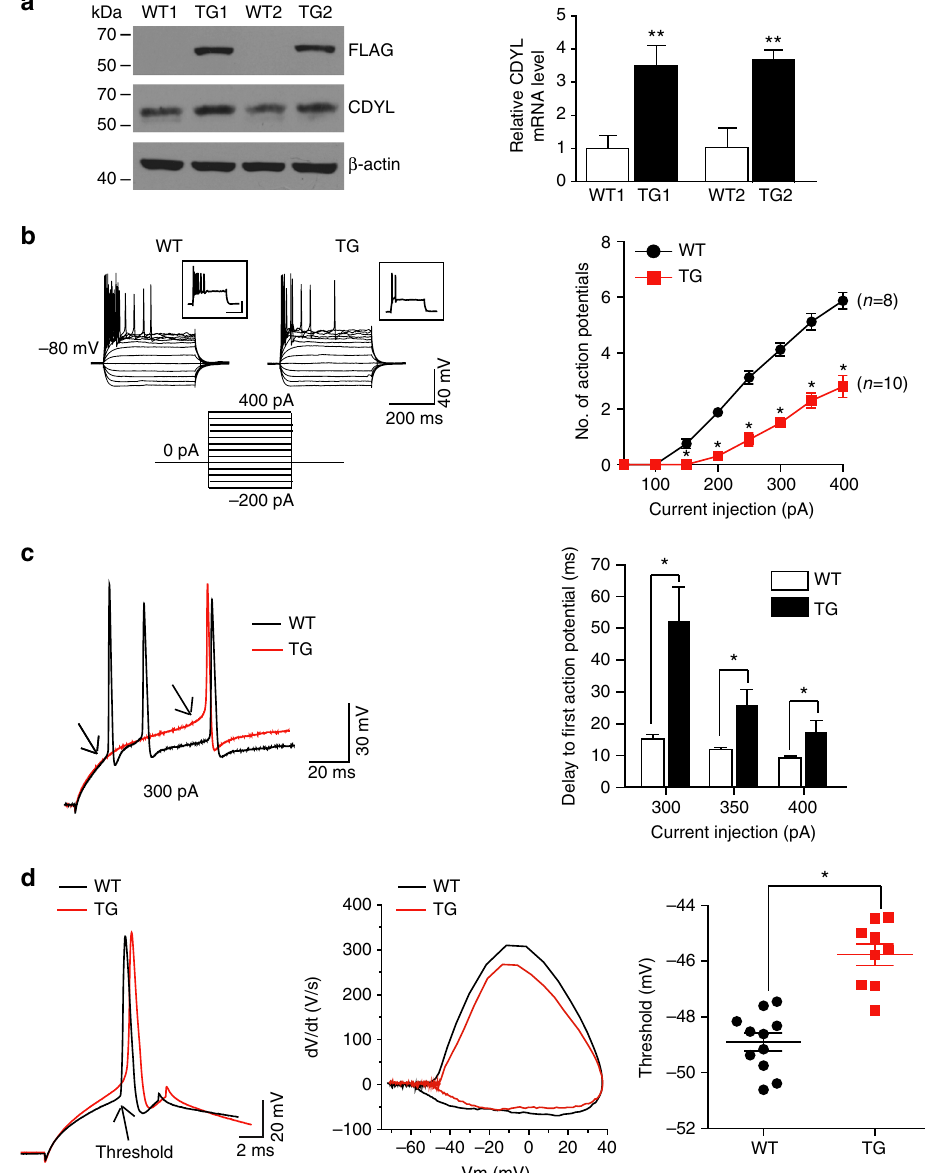
Fig. 3 Over expression of CDYL in vivo signi fi cantly reduced neuronal intrinsic excitability. a Western blotting and real-time RT PCR analysis showed CDYL